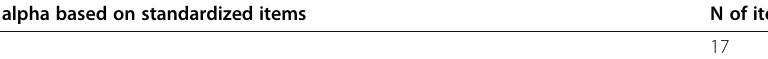
Table 3 Reliability